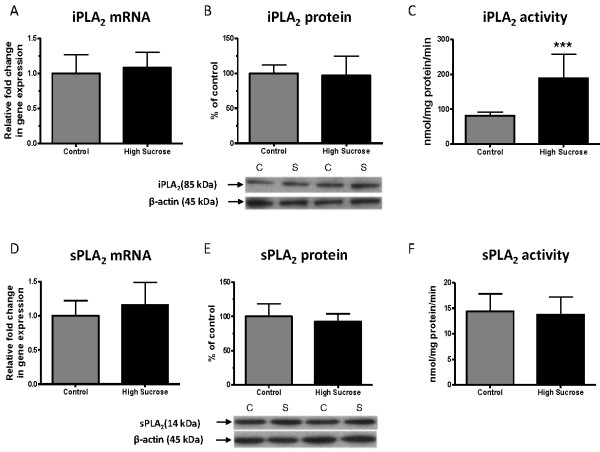
mRNA, protein and activity of brain iPLA2and sPLA2in rats fed the control or high-sucrose diet for 8 weeks. iPLA2 (VIA) A) mRNA, B) protein and C) activity; sPLA2 (IIA) E) mRNA, F) protein and G) activity. Data are expressed as the relative level of the iPLA2 and sPLA2 normalized to the endogenous control (β-globulin) using the ΔΔCT method. Protein level is the ratio of optical density of iPLA2 and sPLA2 to β–actin, expressed as percent of control. Values are mean ± SD (n = 8 for both groups). ***p < 0.001 by unpaired t-test.